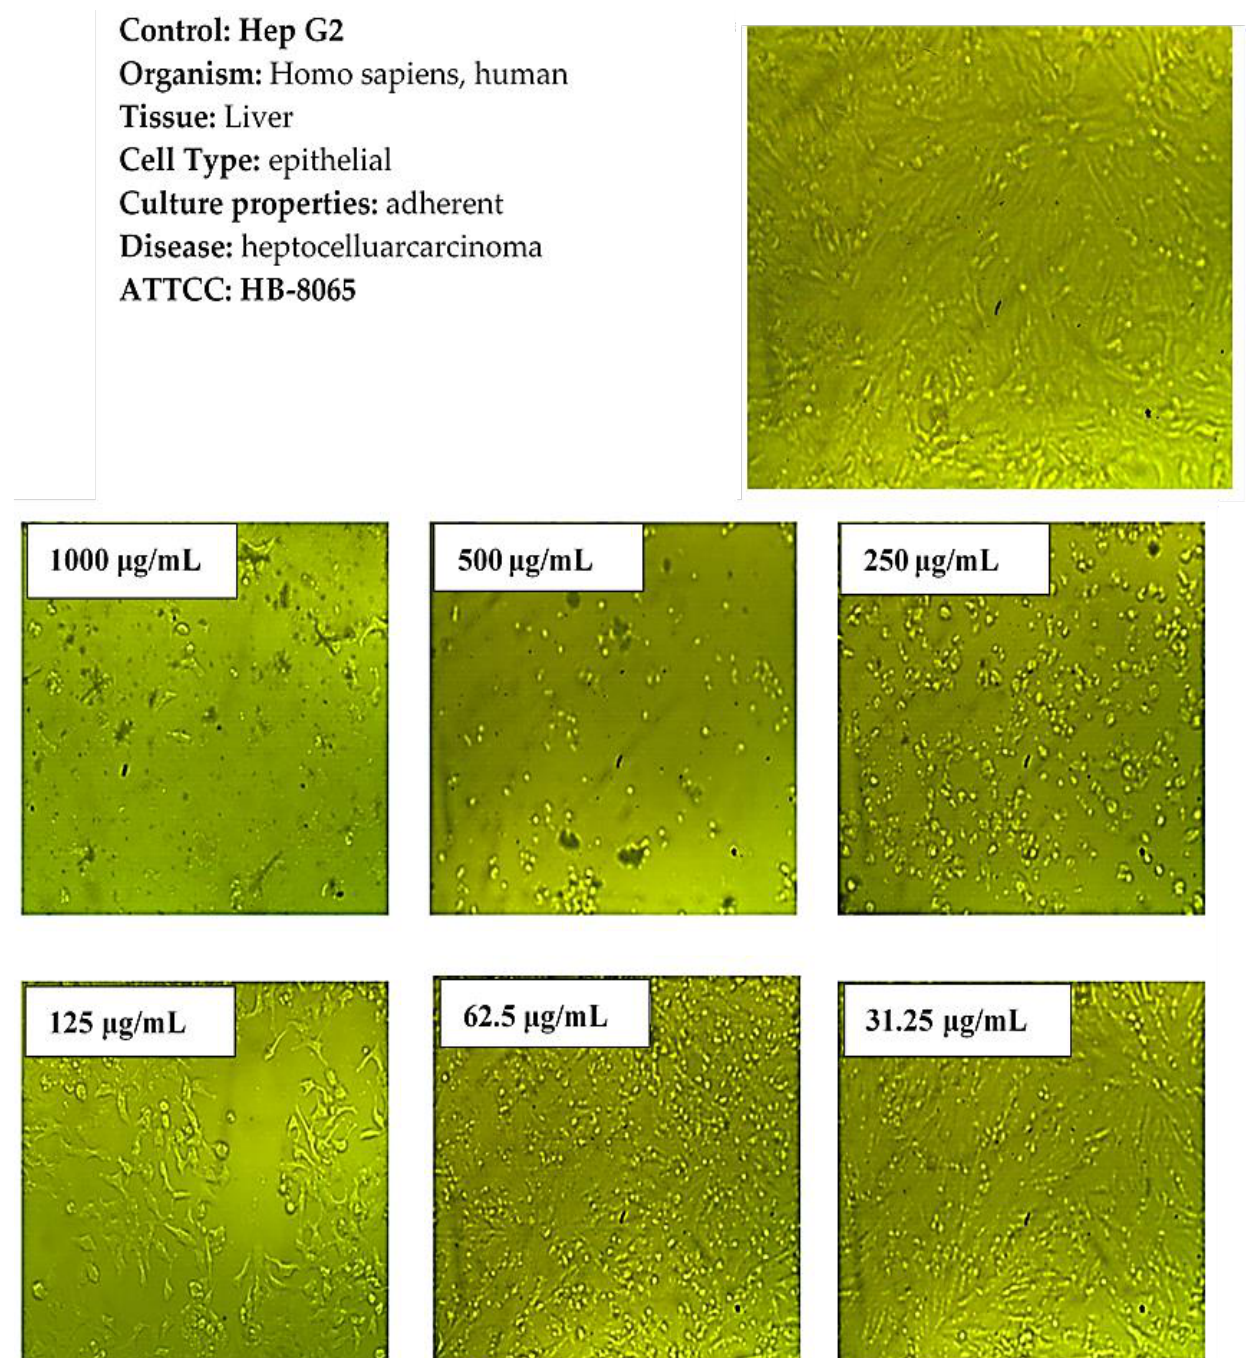
Figure 9. Microscopic images of Hep G2 cancer cells after treatment with various concentrations of Co 3 O 4 NPs synthesized using rosemary leaf extract.